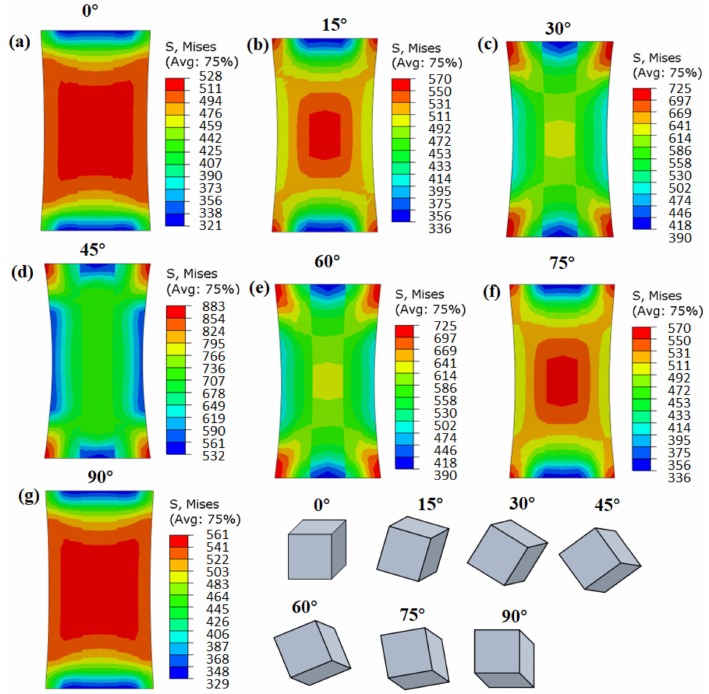
Figure 5. CPFEM simulation results of effective stress for columnar single crystals with different grain orientations: ( a ) 5 ◦ , ( b ) 15 ◦ , ( c ) 30 ◦ , ( d ) 45 ◦ , ( e ) 60 ◦ , ( f ) 75 ◦ , and ( g ) 90 ◦ . σ max . − σ min . Stress uni f ormity =